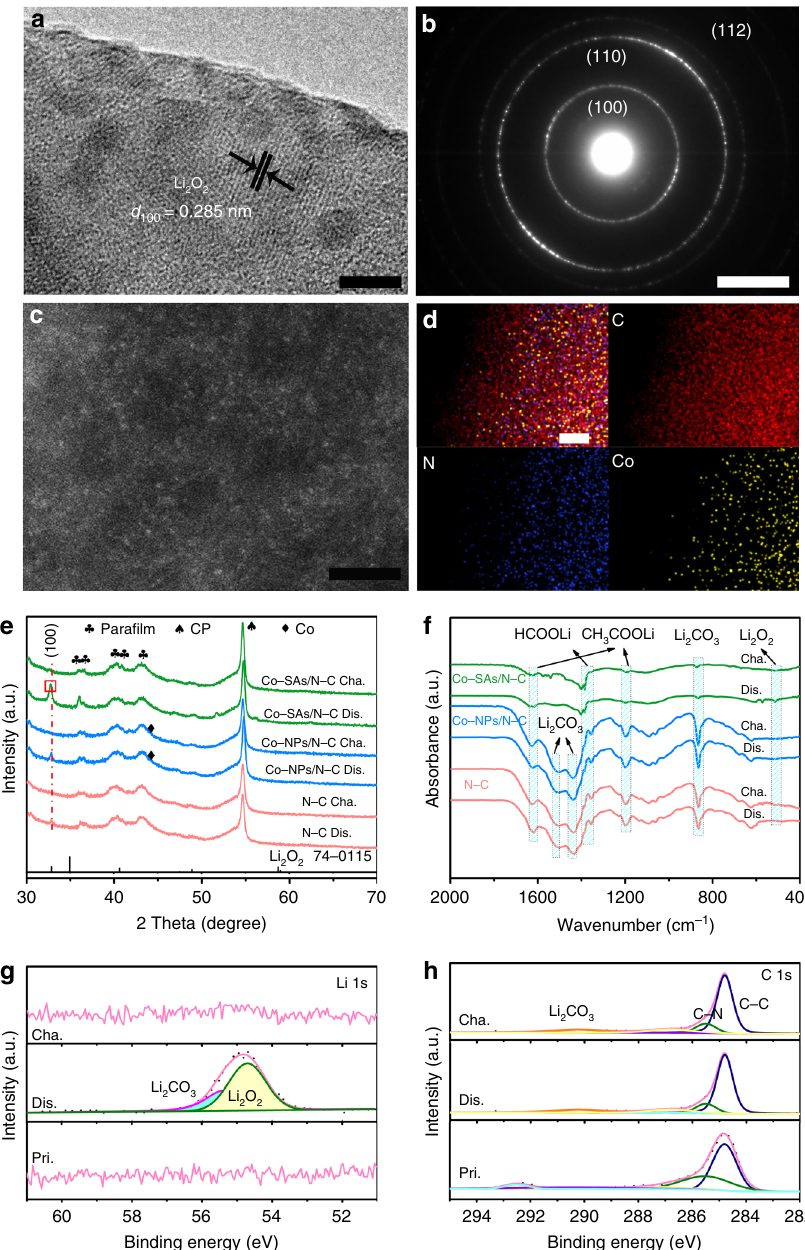
Fig. 4 Ex situ characterizations of discharged and charged electrodes. a Ex situ HRTEM image of fully discharged Co-SAs/N-C. b Ex situ electron diffraction pattern of fully discharged Co-SAs/N-C. c , d Ex situ HAADF-STEM and mapping images of Co-SAs/N-C after the 1st cycle. e Ex situ XRD patterns of discharged and charged Co-SAs/N-C, Co-NPs/N-C and N/C electrodes during the 1st cycle. f Ex situ FTIR spectra of the discharged/charged electrodes at the 10th cycle. g , h Ex situ XPS spectra of pristine, discharged and recharged Co-SAs/N-C electrode in Li 1s and C 1s regions at the 10th cycle. Pristine, Discharged and Charged are abbreviated as Pri., Dis. and Cha.,